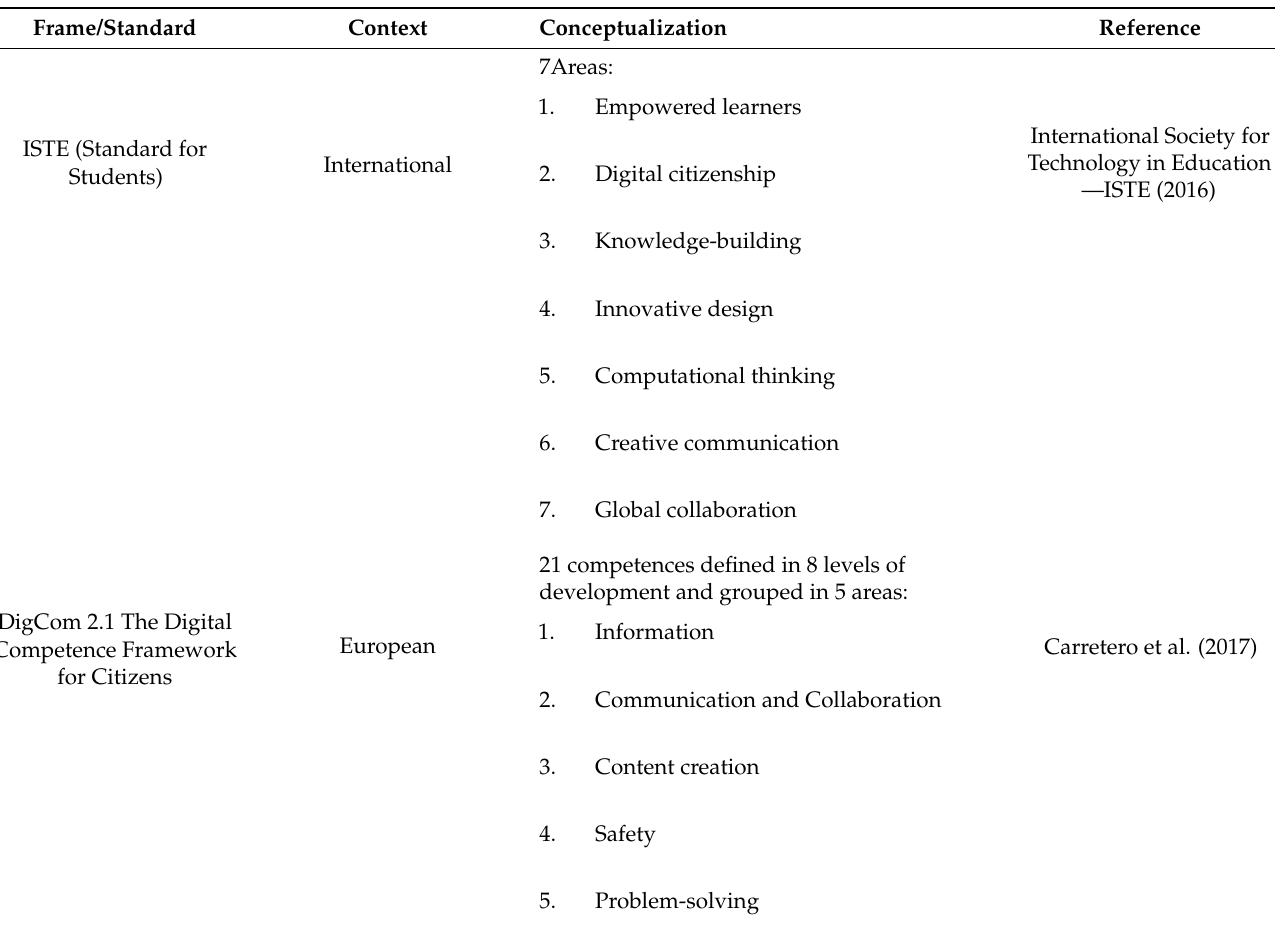
Table 1. Frameworks and benchmarks on the conceptualization and assessment of